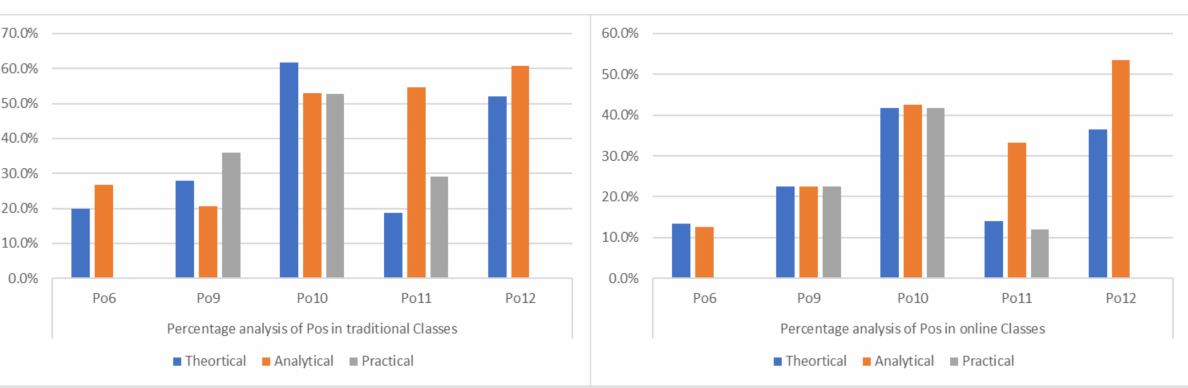
Fig. 5. Percentage Analysis of PO’s in Traditional and online